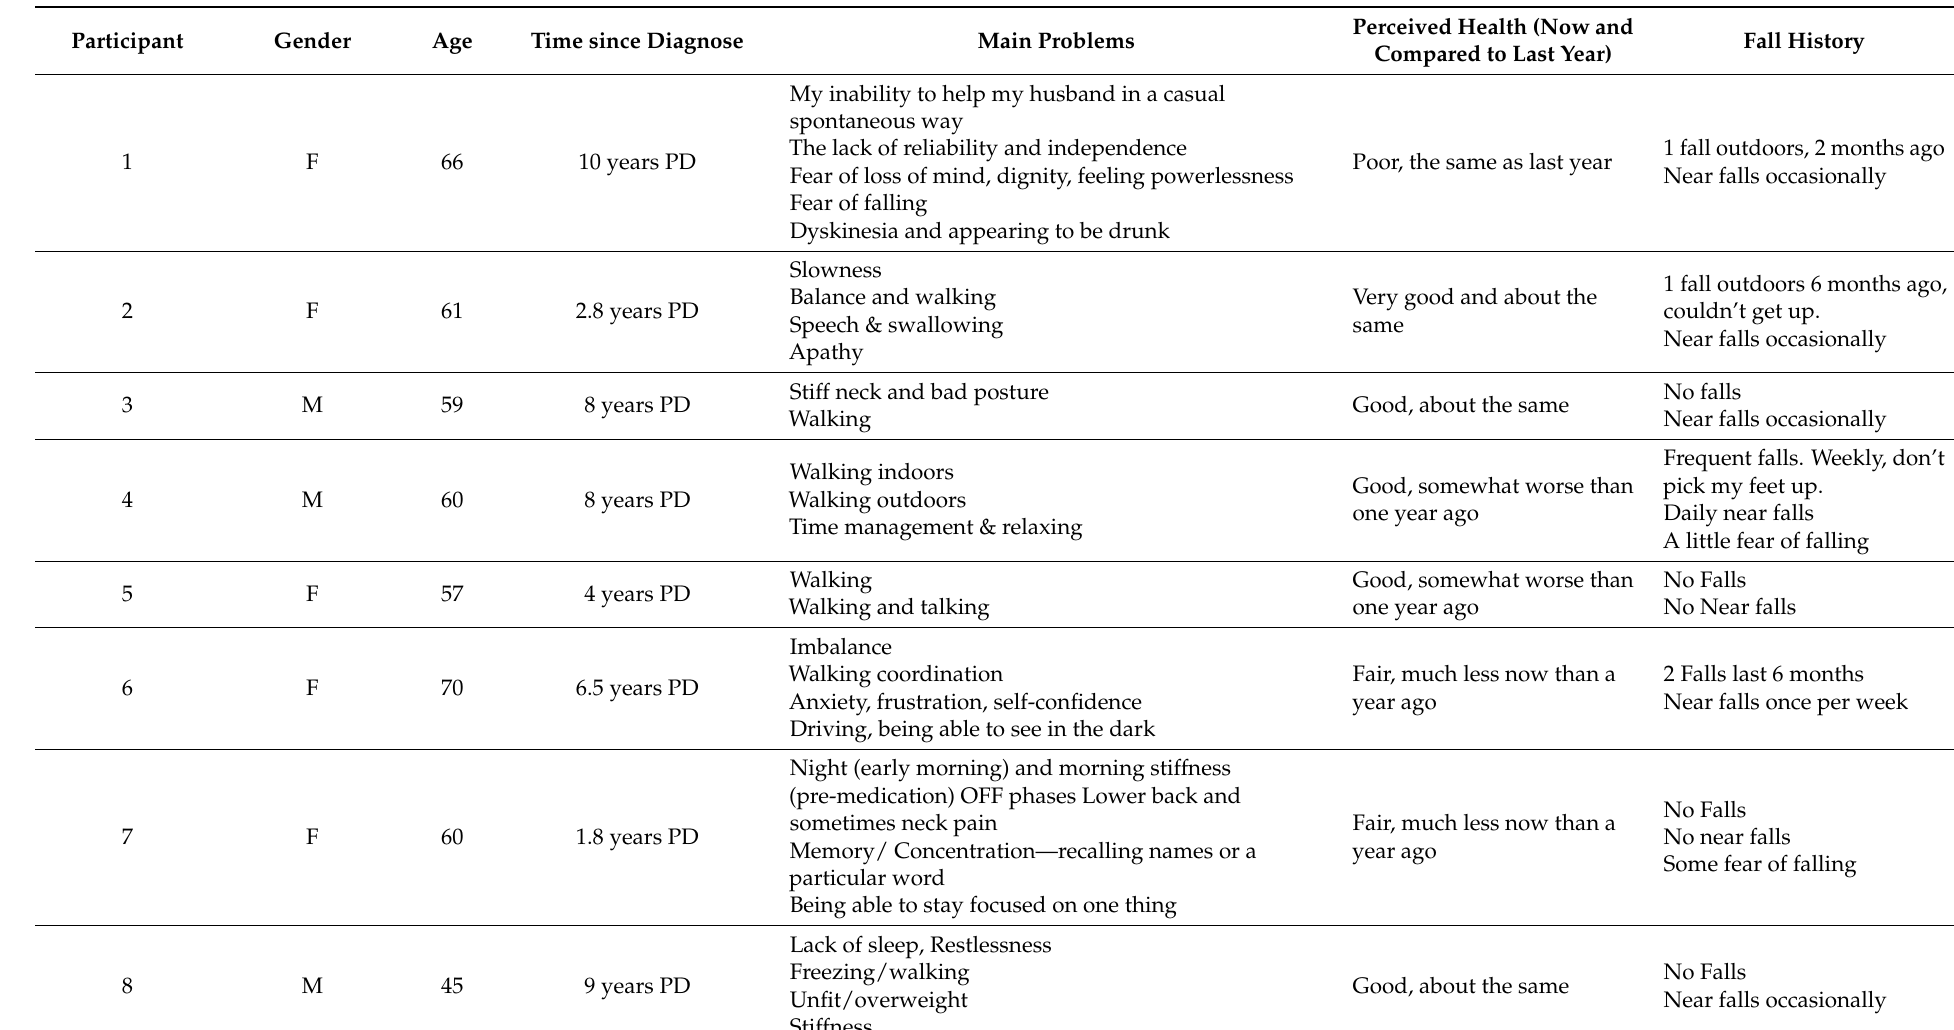
Table 1. Participants’ general and clinical